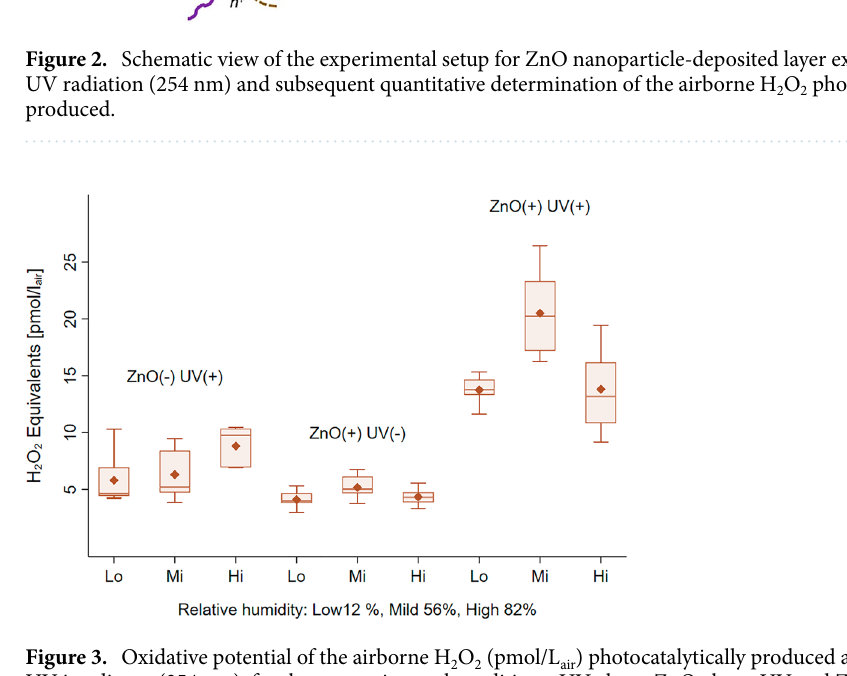
Figure 3. Oxidative potential of the airborne H 2 O 2 (pmol/L air ) photocatalytically produced after exposure to UV irradiance (254 nm), for three experimental conditions: UV alone, ZnO alone, UV and